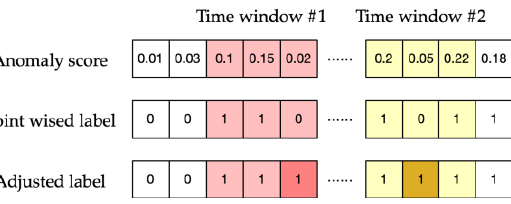
Figure 9. Illustration of the strategy for label adjusting.